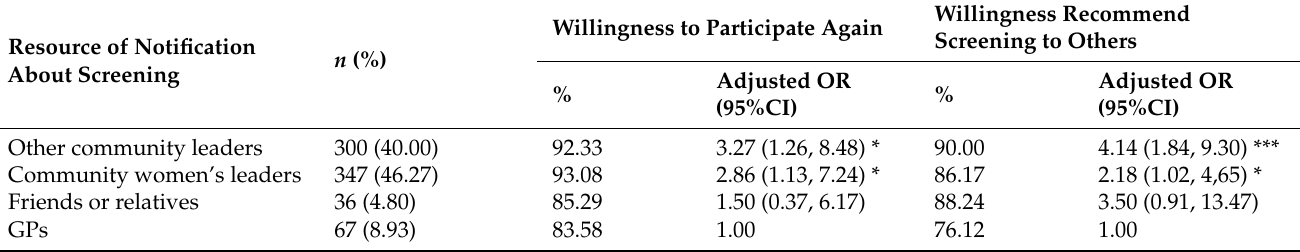
Table 5. The association of the resource of notification about screening with the willingness to participate again and to recommend screening to others of organized breast and cervical cancer screening in rural China